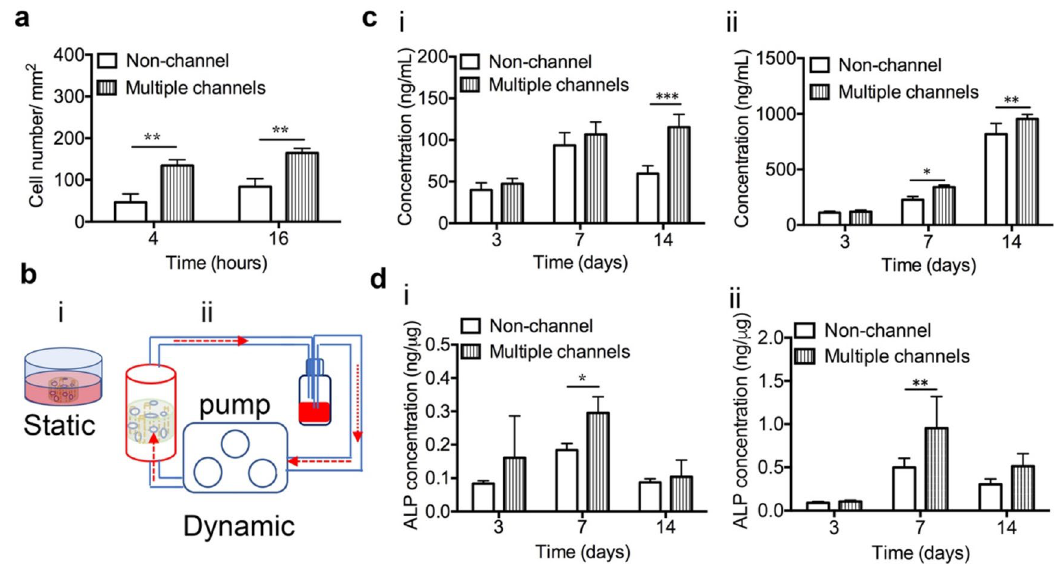
Figure 2. Cell attachment, proliferation, and ALP activity: ( a ) Cell number of hBMSCs attached on the two types of scaffolds after 4 and 16 h. ( b ) HBMSCs were cultured in the scaffolds under two culture conditions: (i) static culture; (ii) dynamic culture. ( c ) Cell proliferation of hBMSCs under the static condition (i) and dynamic condition (ii). ( d ) ALP concentrations of hBMSCs under the static condition (i) and dynamic condition (ii). (n = 3, * p < 0.05, ** p < 0.01, *** p <